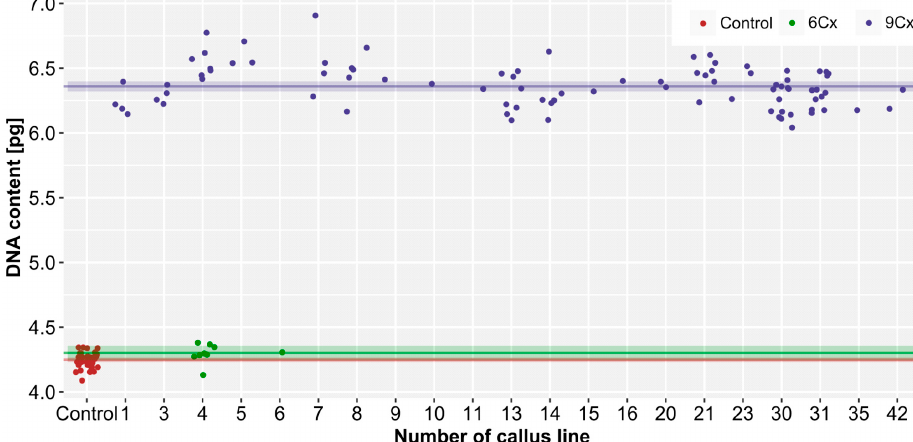
Figure 2. Nuclear DNA content of seedlings (6Cx control) and endosperm-derived plants (6Cx and 9Cx regenerants) of Actinidia chinensis var. deliciosa . The points represent 2C values of individual plants, and are scattered randomly to the right and left above the given number of callus lines to avoid overlapping the same or very similar values. The horizontal lines accompanied by semi-transparent bands in the appropriate colours show the mean values and 95% confidence intervals (CI) for the sets of measurements in order of DNA content. Note that from endosperm-derived callus line no. 4, both 6Cx and 9Cx plants were regenerated.